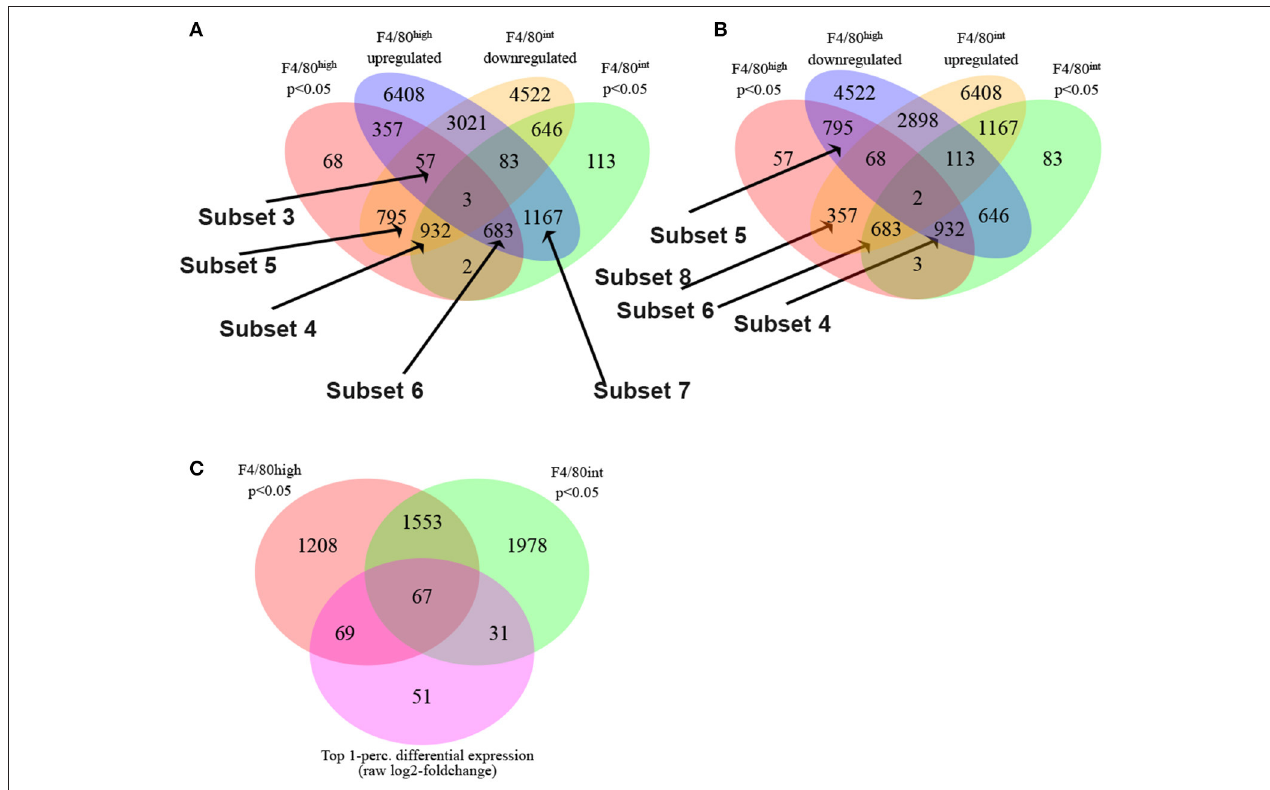
FIGURE 2 | S. mansoni infection induces profound transcriptional alterations to Kupffer cells and Perivascular macrophages. (A,B) The Boolean strategies described in the methods are illustrated in the Venn diagrams: The following set designations were used in the set